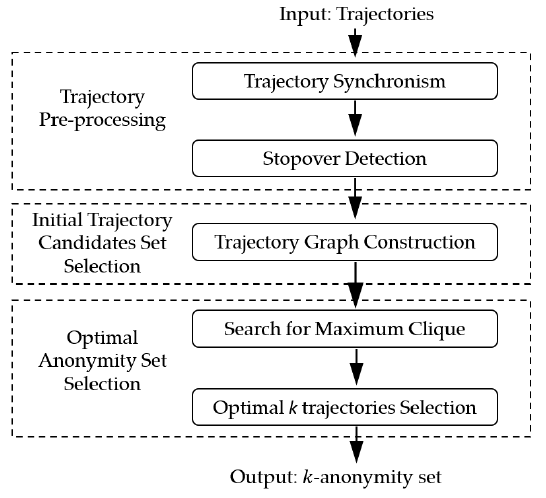
Figure 2. Overview of the proposed algorithm.